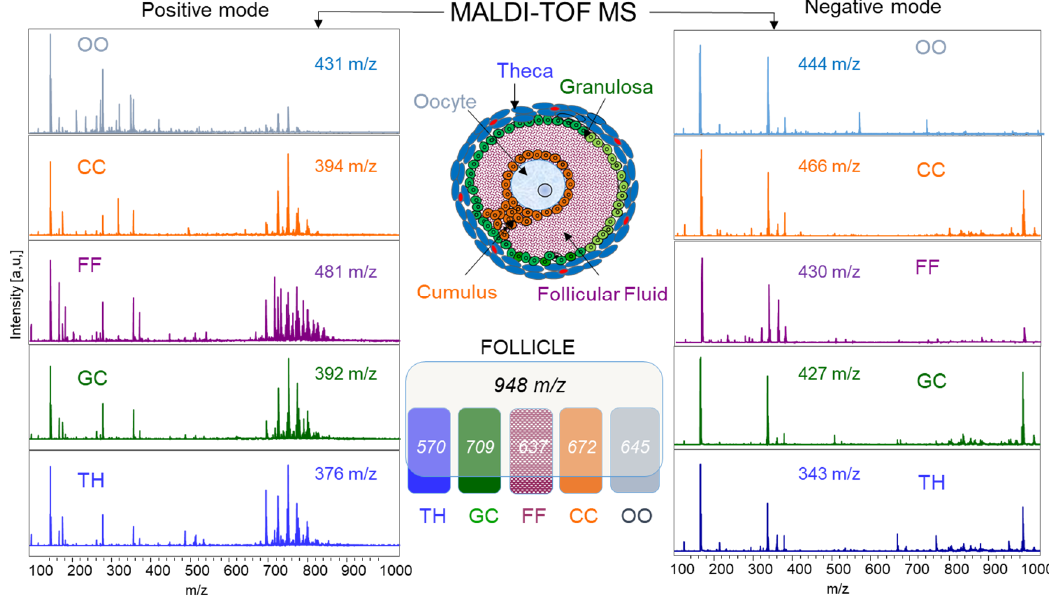
Figure 4. MALDI-TOF profiling performed on isolated follicular compartments. Examples of spectra and number of peaks obtained from individual oocyte (OO), cumulus cells (CC), follicular fluid (FF), granulosa cells (GC) and theca cells (TH) are shown for both positive (left) and negative (right) ion modes. After alignment of spectra from all of the compartments, 948 m / z were detected from the average spectrum. The number of common peaks between the compartments and the whole follicle are indicated in white italics.